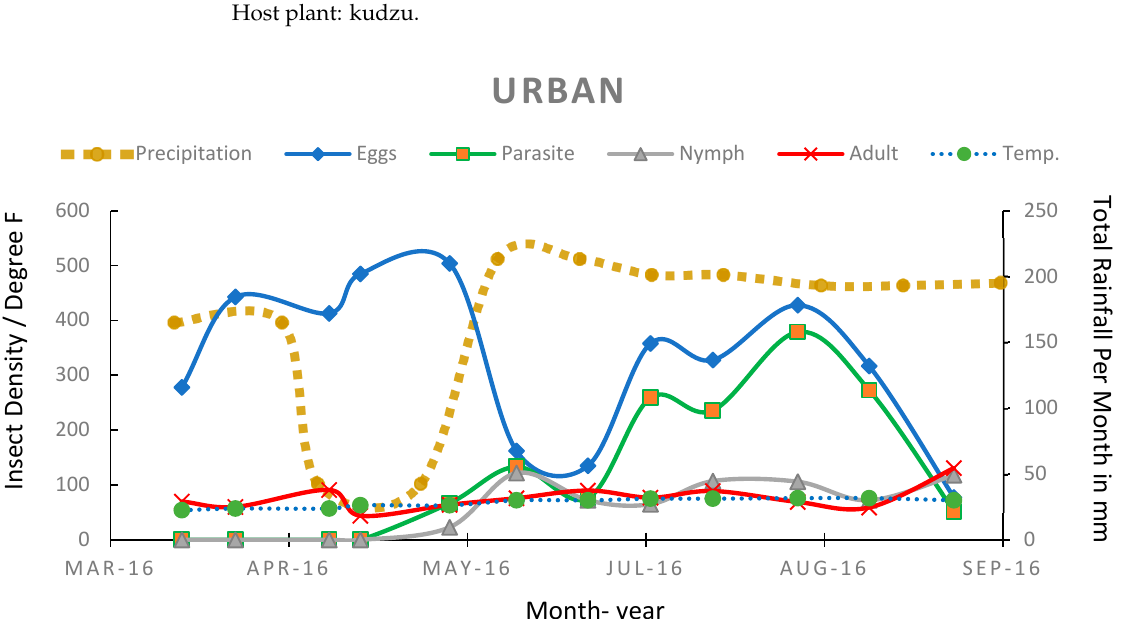
Figure 3. Population dynamics of M. cribraria and P. saccharalis for most active urban site in 2016. Host plant: kudzu.